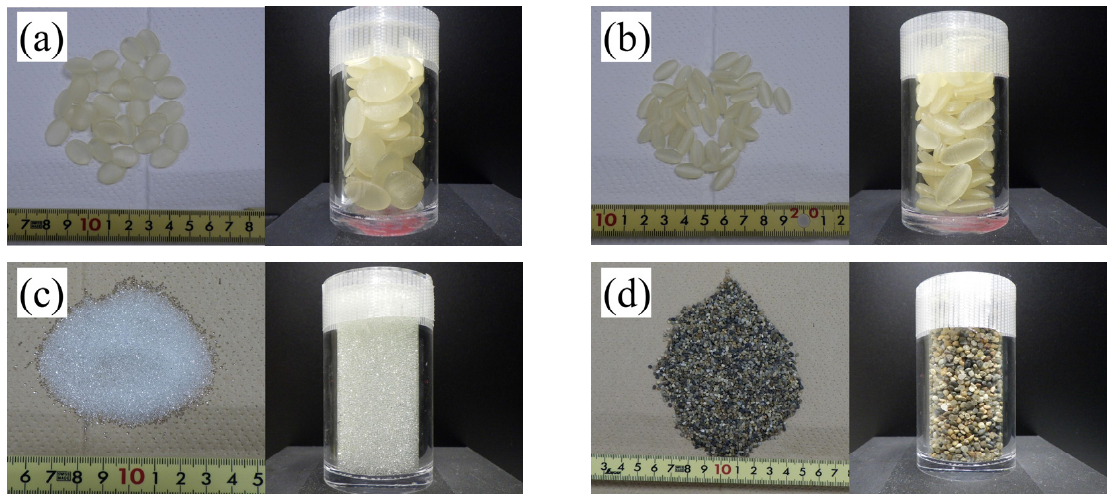
Figure 3. Acrylic glass columns filled with the materials: ( a ) RP1 and ( b ) RP2 (resin particles made by a 3D printer), ( c ) GBs (glass beads), and ( d ) KS (Kashima–Keisa natural sand).